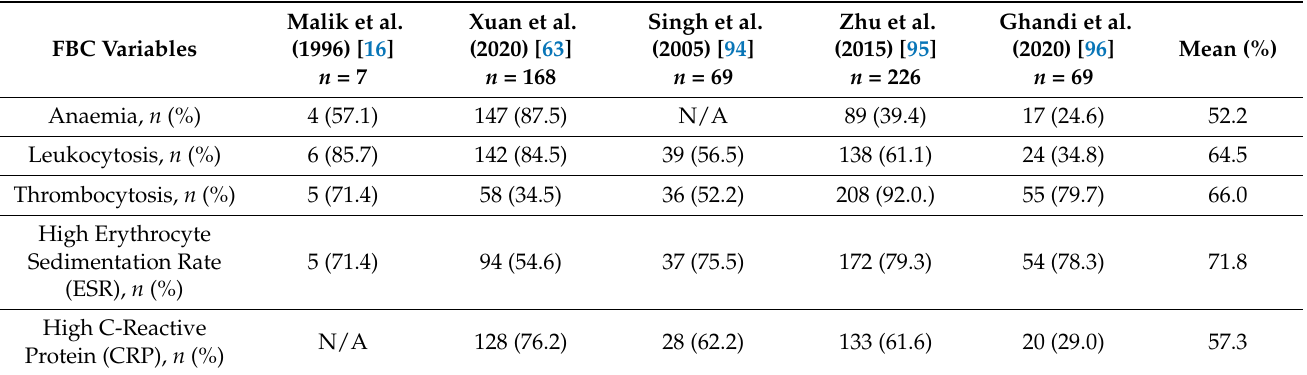
Table 2. Comparison of Full Blood Count (FBC) abnormalities of different studies in KD (selected based on the FBC